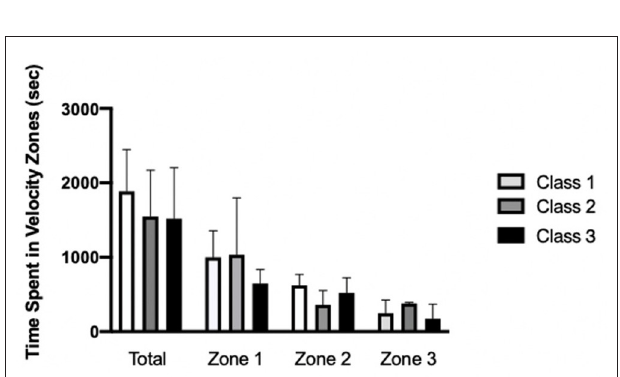
FIGURE 2 | Mean time spent in different velocity zones (Zones 1–3) during a wheelchair rugby game and movement time for Class 1 ( n = 4), 2 ( n = 4), and 3 ( n = 3). p >